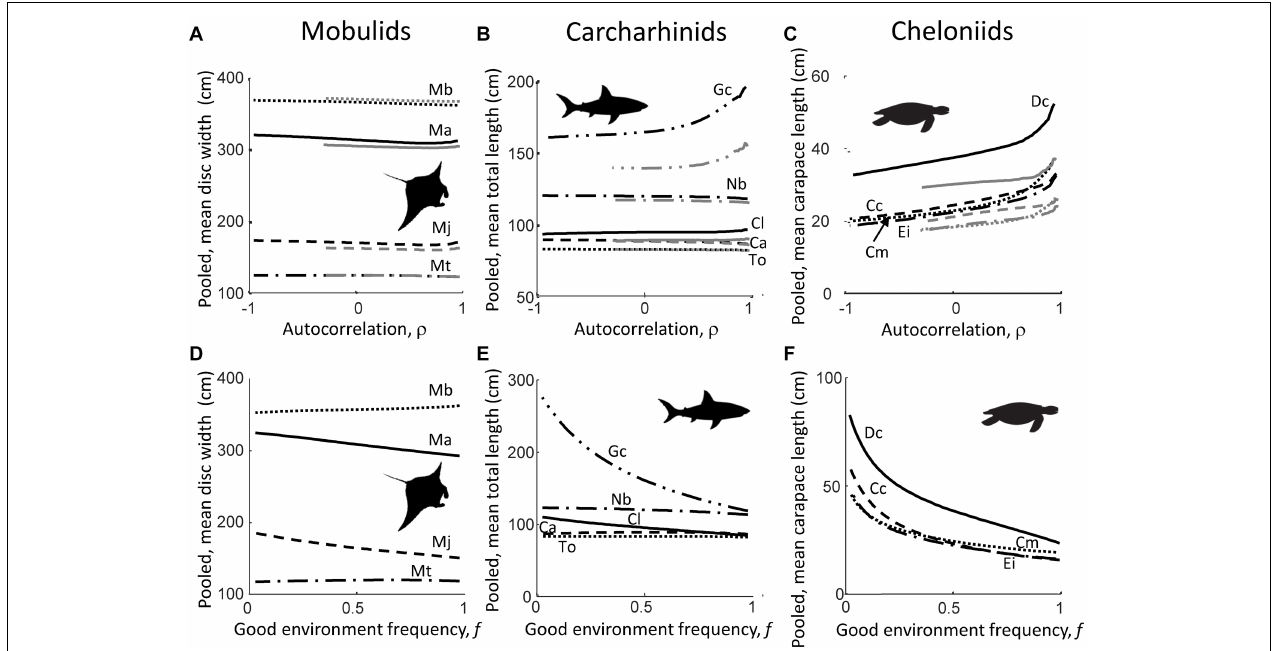
FIGURE 2 | Shifts in pooled mean body size across the gradient of environmental autocorrelation ρ (A–C) , and across the gradient of good environment frequency f ranging from almost zero to almost unity (D,E) , for mobulids (A,D) , carcharhinids (B,E) , and cheloniids (C,F) . Black lines in (A–C) are pooled, mean body size values when the good environment frequency is fixed at f = 0.5; gray lines when f = 0.75. Mobulid species are M. alfredi (Ma; solid lines), M. birostris (Mb; dotted lines), M. japonica (Mj; dashed lines), and M. thurstoni (Mj; dash-dot lines); carcharhinid species are C. limbatus (Cl; solid lines), T. obesus (To; dotted lines), C. amblyrhynchos (Ca; dashed lines), N. brevirostris (Nb; dash-dot lines), and G. cuvier (Gc; dash-dot-dot lines); cheloniid species are D. coriacea (Dc; solid lines), C. mydas (Cm; dotted lines), C. caretta (Cc; dashed lines), and E. imbricatea (Ei; dash-dot lines). Note difference in y-scale between panels.